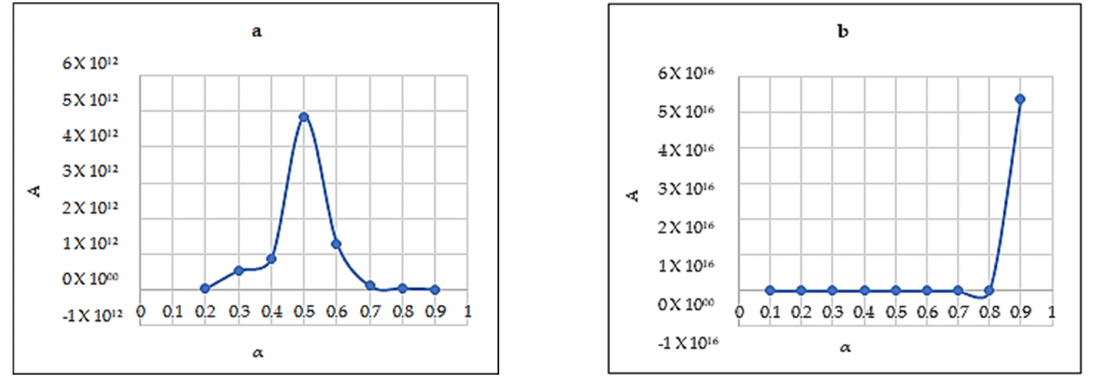
Figure 5. Variation of frequency factor with conversion values for sample CS:WPCBs; ( a ) first zone, and ( b ) second